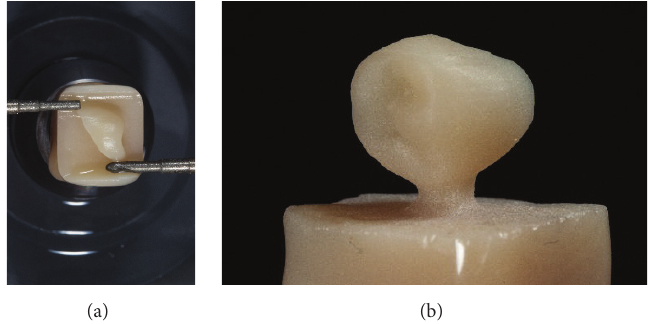
Figure 6: Wet grinding process of the partial crown using the CEREC MXCL (Sirona Bensheim, Germany) unit.